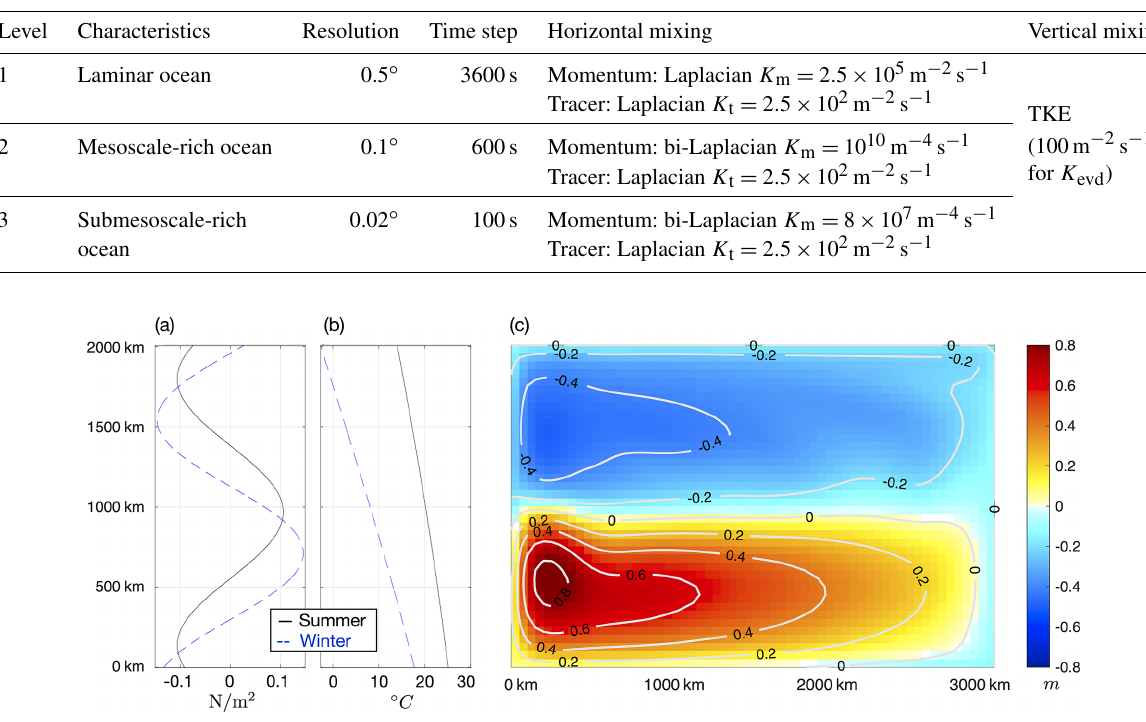
Figure 5. Zonal wind stress (a) , sea-surface temperature (b) , and the sea-surface height climatology under 0.5 ◦ resolution (c) .